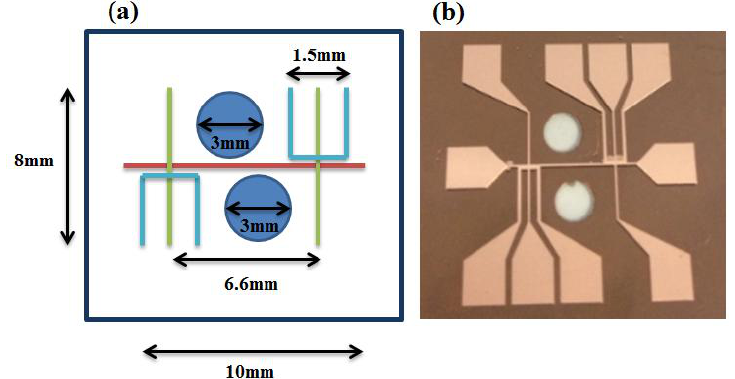
Figure 1. ( a ) Schematic of a final chosen transparent atom chip design with a combination of U and H-wire trap pattern design. ( b ) Photograph of a fabricated transparent atom